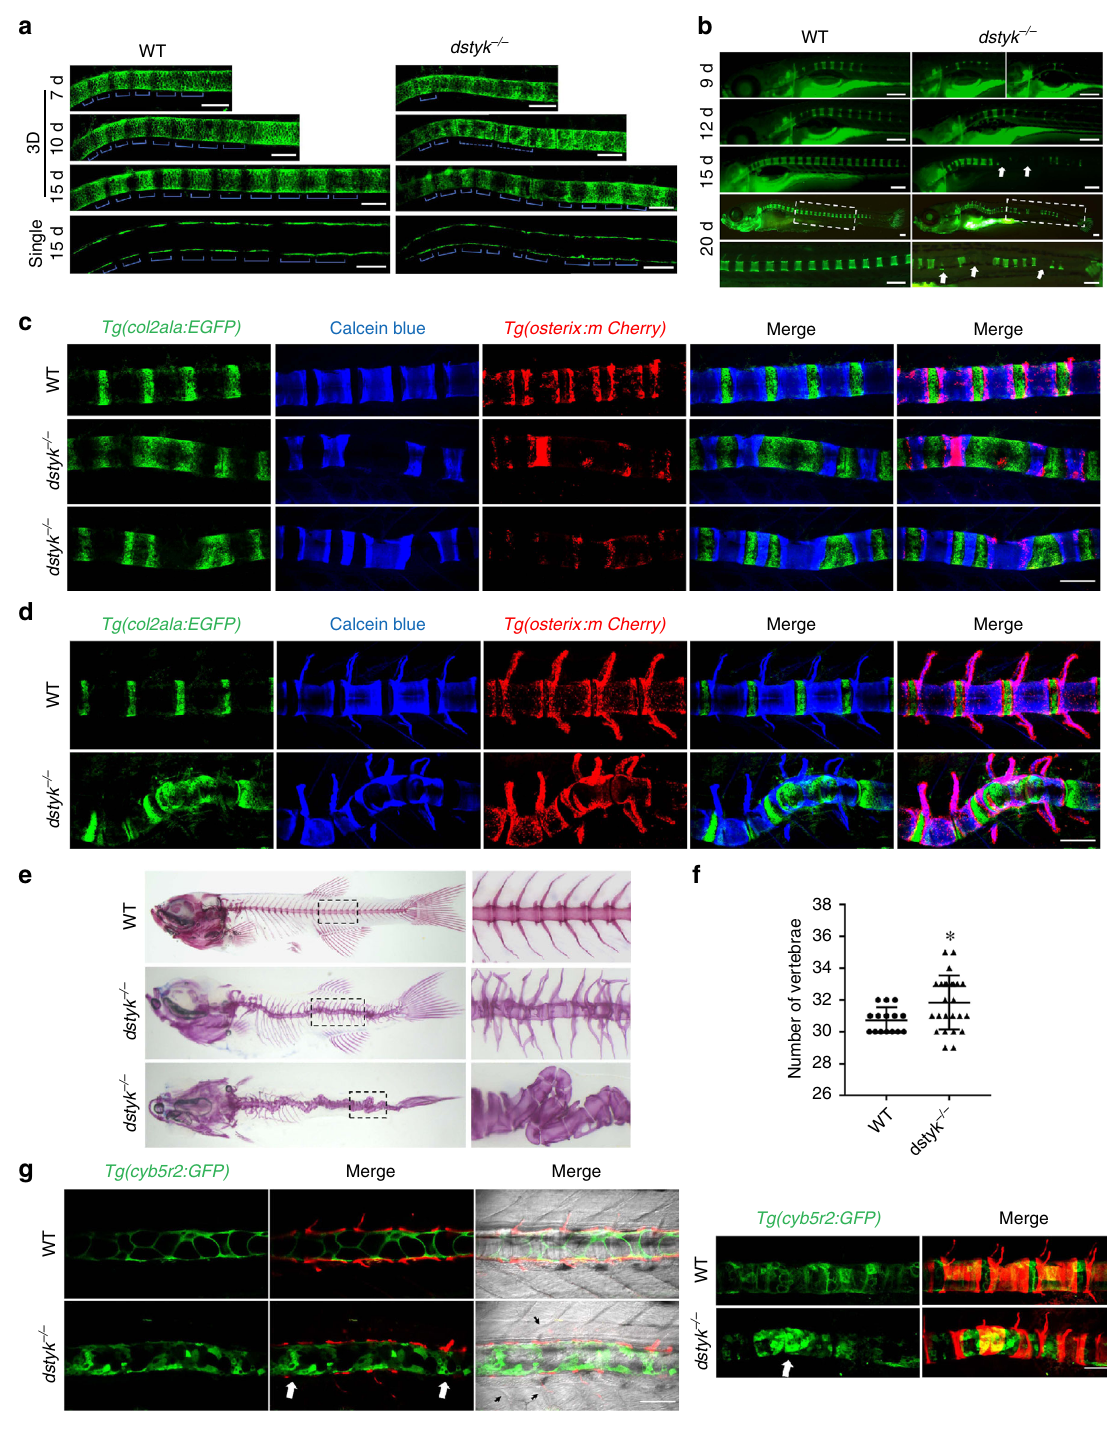
colocalization of DSTYK-GFP with LAMP1-mCherry on the vacuole membrane and lysosomes (Fig. 8e). These in vivo studies indicate that Dstyk has consistent localization as those obtained in cultured human cells. To further assess the effects of DSTYK de fi ciency on lysosome biogenesis, we evaluated the lysosome numbers in COS-7 cells with Red. We found that lysosome numbers and fl uorescence intensity were reduced after Dstyk knockdown (Fig. 8f, g), and decreased levels of LAMP1 and LAMP3 (Fig. 8h, Fig. 9b). Similar results were also observed in HeLa cells (Supplementary Fig. 5a).